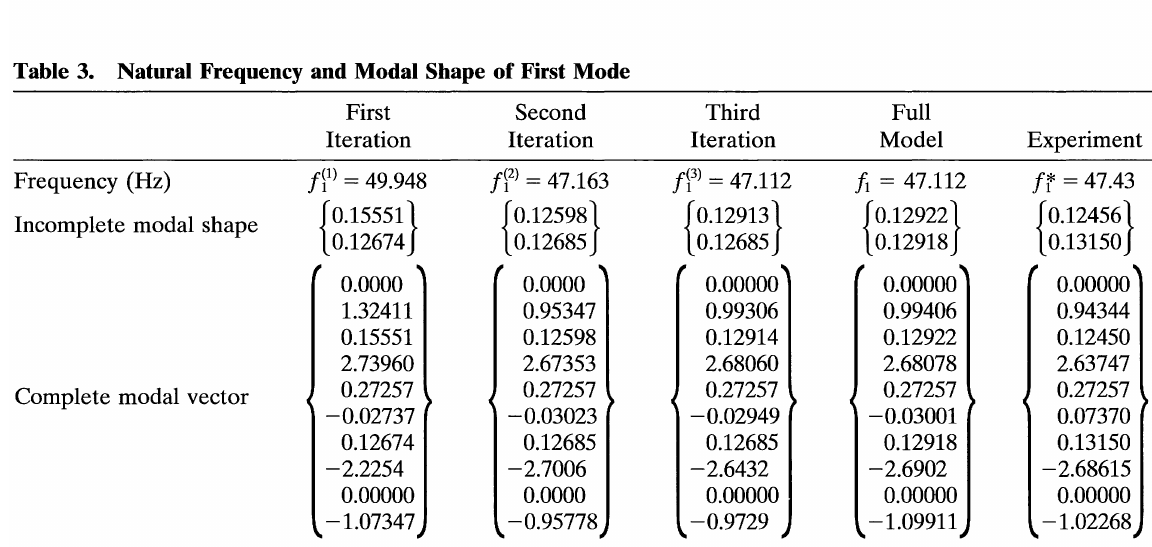
Table 3. Natural Frequency and Modal Shape of First